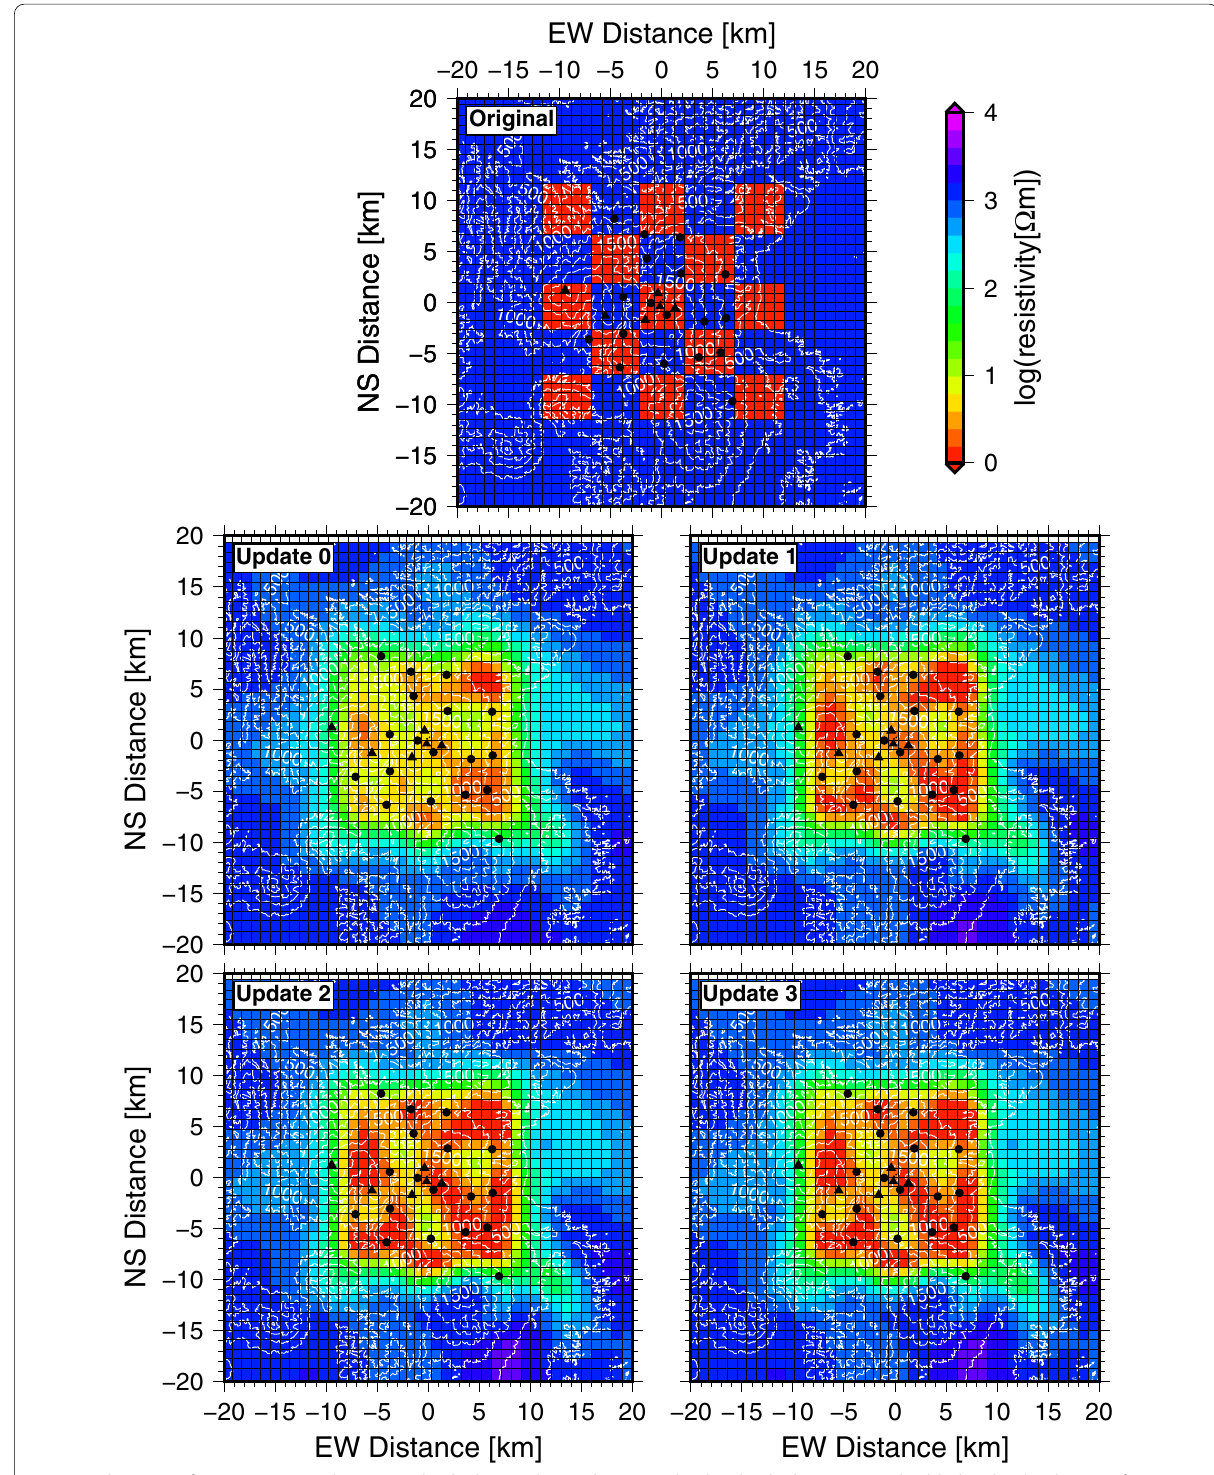
Fig. 11 Plan view of CRT as in Fig. 10, but using checkerboxes about 5 km to a side. The checkerboxes are embedded in the depth range from 5 to 10 km bsl, and the output models are shown at the depth of 7.5 km